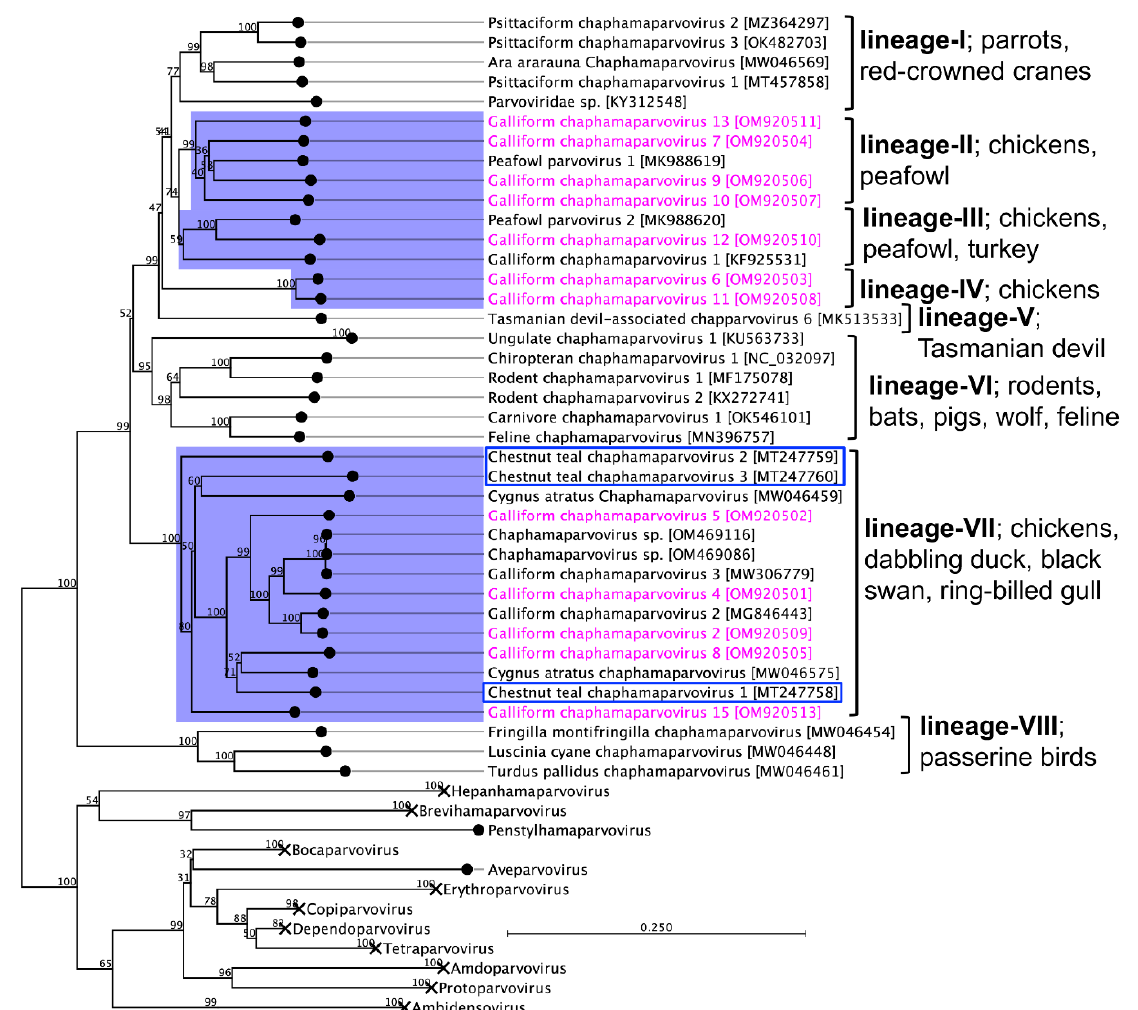
Figure 4. Maximum likelihood phylogenetic tree shows the possible evolutionary relationship of novel galliform chaphamaparvoviruses (GaChPVs) detected in this study with other selected parvoviruses. The numbers on the left show bootstrap values as percentages, and the labels at the branch tips refer to the original parvoviruses’ species names (followed by the GenBank accession numbers in parentheses). The clade correspondence to the chaphamaparvoviruses sequenced in this study has a purple background, and the GaChPVs sequenced in this study are shown in pink. All other clades relevant to other genera are collapsed (details tree under Supplementary Figure S1). Blue box indicates chaphamaparvoviruses sequenced previously from Australian birds.